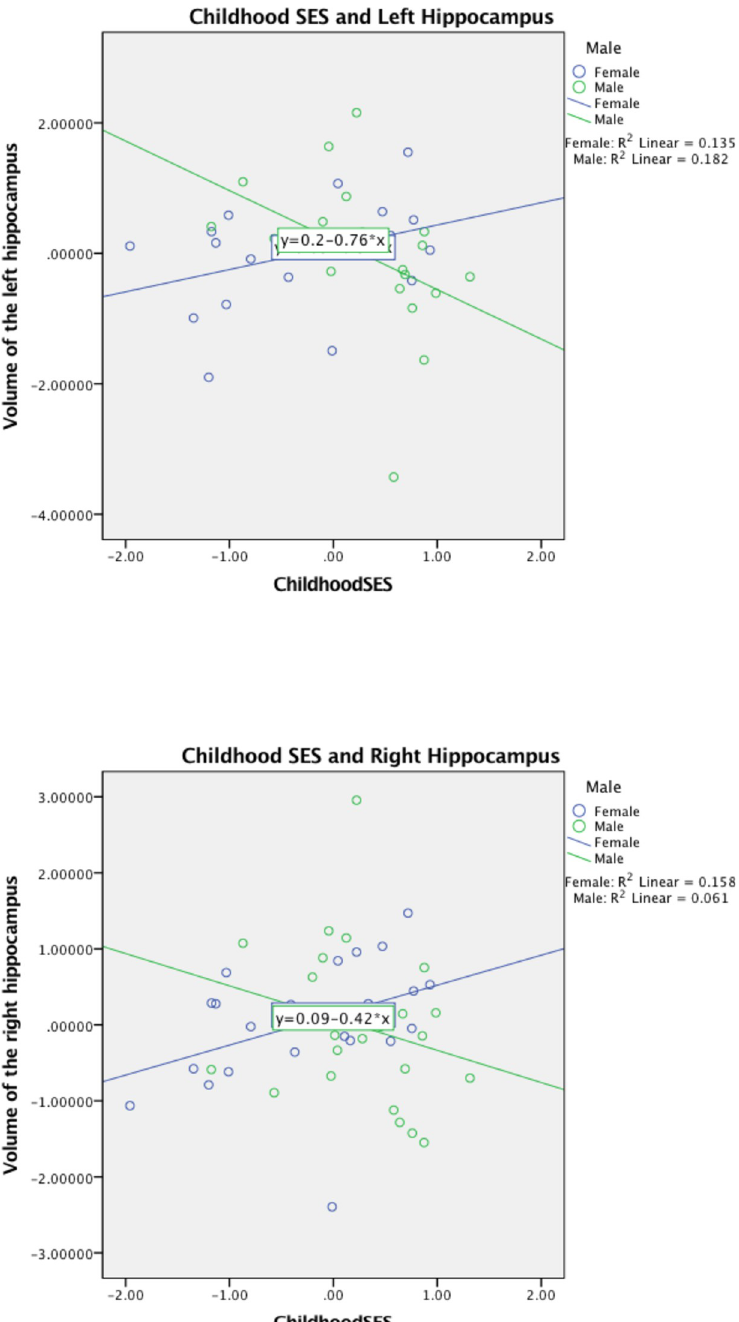
Fig 2. Hippocampal volume as a function of childhood SES for males and females., adjusted for childhood maltreatment, current SES, recent negative interpersonal events, age, total brain volume, and